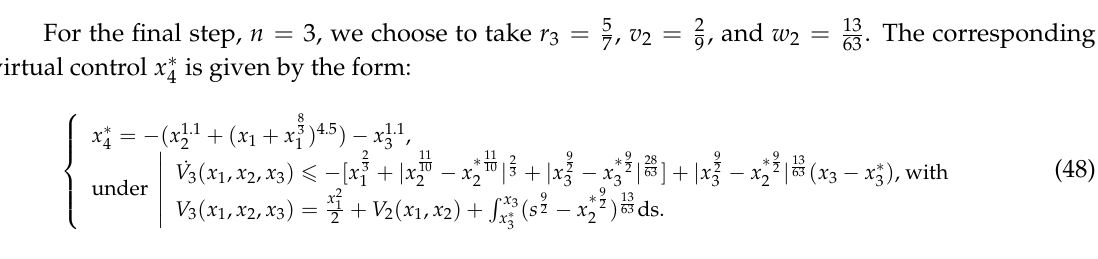
Figure 2. Initial condition response of a finite-time stabilized double